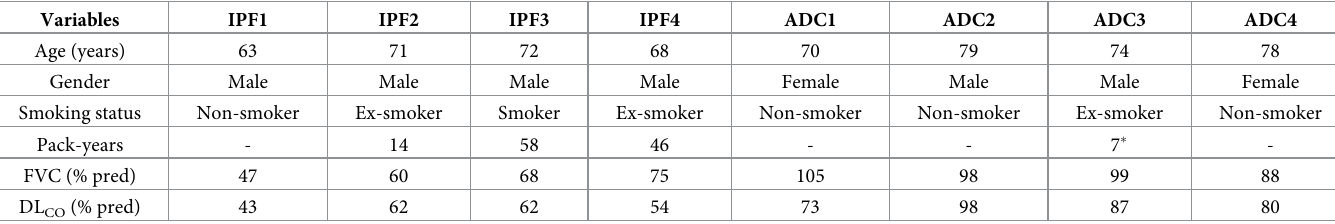
Table 1. Clinical characteristics of the study subjects examined in the microarray